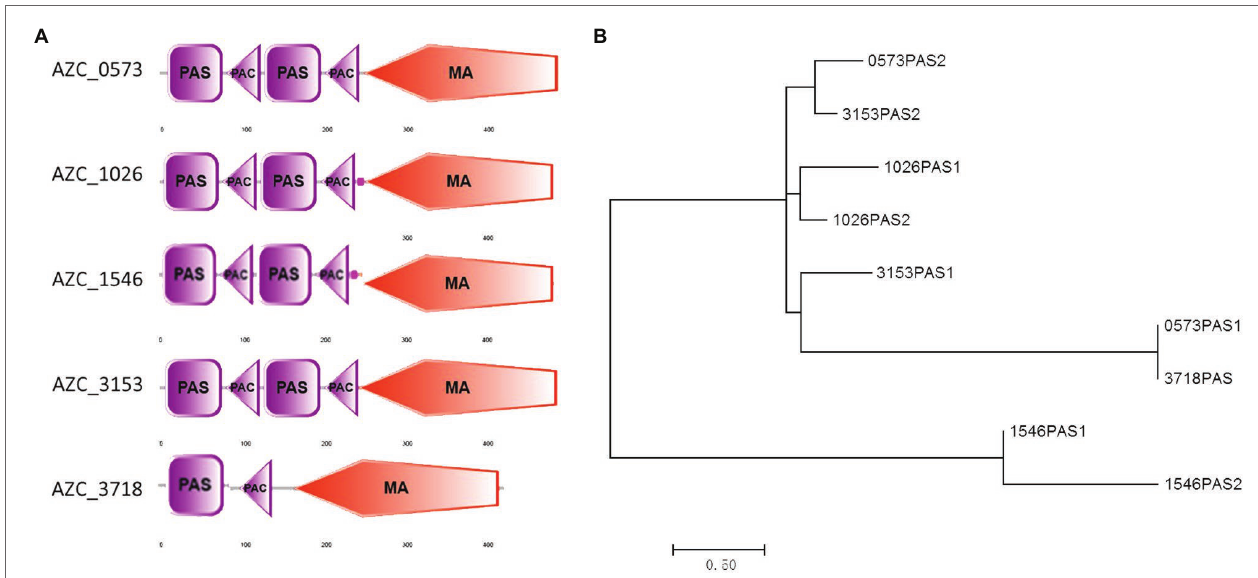
FIGURE 5 | Analysis of soluble receptors in A. caulinodans ORS571. The domains in each receptor were showed on the schematic diagram (A) . The phylogenetic tree of PAS domains based on an alignment of amino acids sequences by MEGA7 (B) .